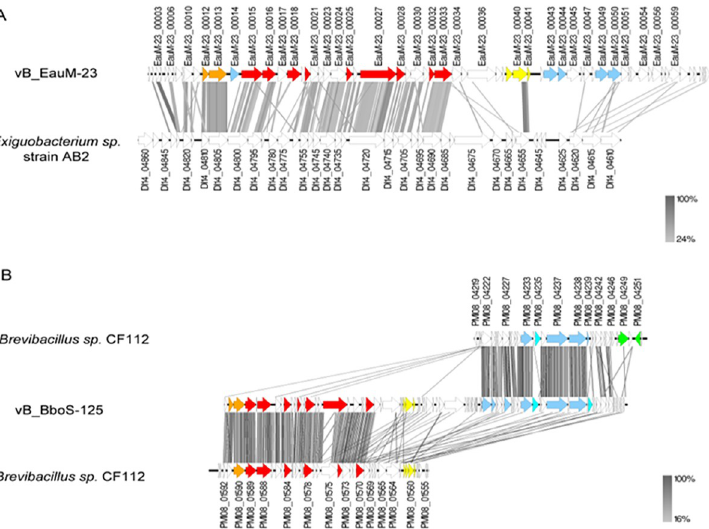
Fig 5. Genomic comparisons of isolated phages vB_EauM-23 (A) and vB_BboS-125 (B) of this study with not annotated prophage regions in bacterial genomes. Functional clusters are marked by the same colour, namely DNA packaging (orange), structural components (red), lysis (yellow), regulation (green), replication (blue) and nucleotide metabolism (turquois). Synteny plot was generated with Easyfig with amino acid sequence comparison [33]. The amino acid sequence identity range is indicated by a gradient